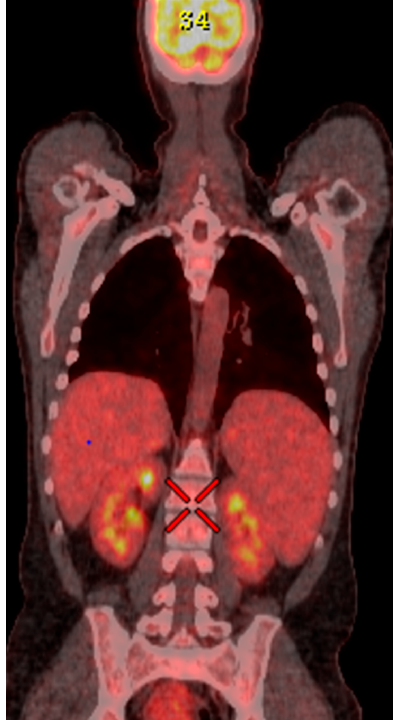
Figure 2. 18-FDG-PET shows diffuse metabolic activity within the liver, spleen, and whole bone marrow. Characteristics: coronal Ex: 14,321, Se, 12 STATIC, P: 68,36, DFOV: 172.9 × 98.8 cm, M: 13.11 kBq/mL.